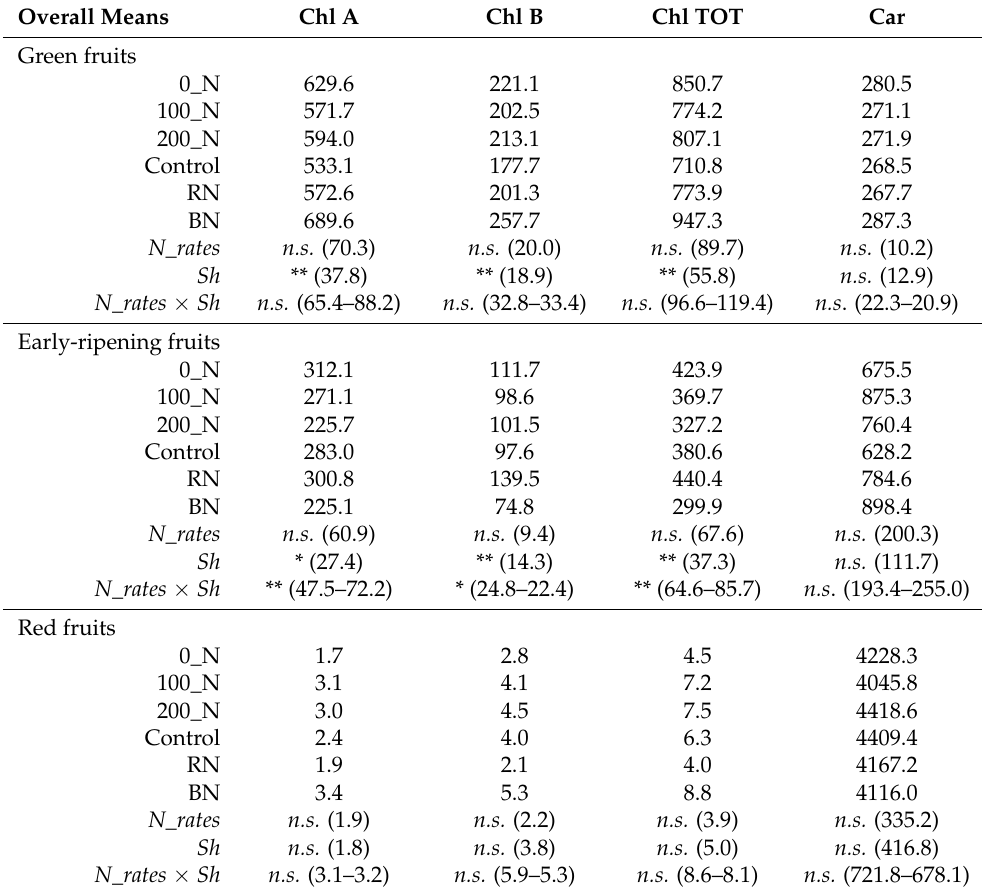
Table 3. Overall means and F-test from the analysis of variance (ANOVA a ) performed on pigment content [Chlorophyll (Chl) A, Chl B, Chl TOT (Chl A + Chl B) and Carotenoids (Car); µ g g − 1 dry weight] data. Pigments were analyzed on pepper fruits from plant subjected to different N fertilization rates (N_rates; 0_N: 0 kg N ha − 1 ; 100_N: 100 kg N ha − 1 ; 200_N: 200 kg N ha − 1 ) and shade levels (Sh; accomplished using: no cover, Control; red photoselective net, RN; black photoselective net, BN) at harvest (83 days after transplanting, DAT), in 2017.